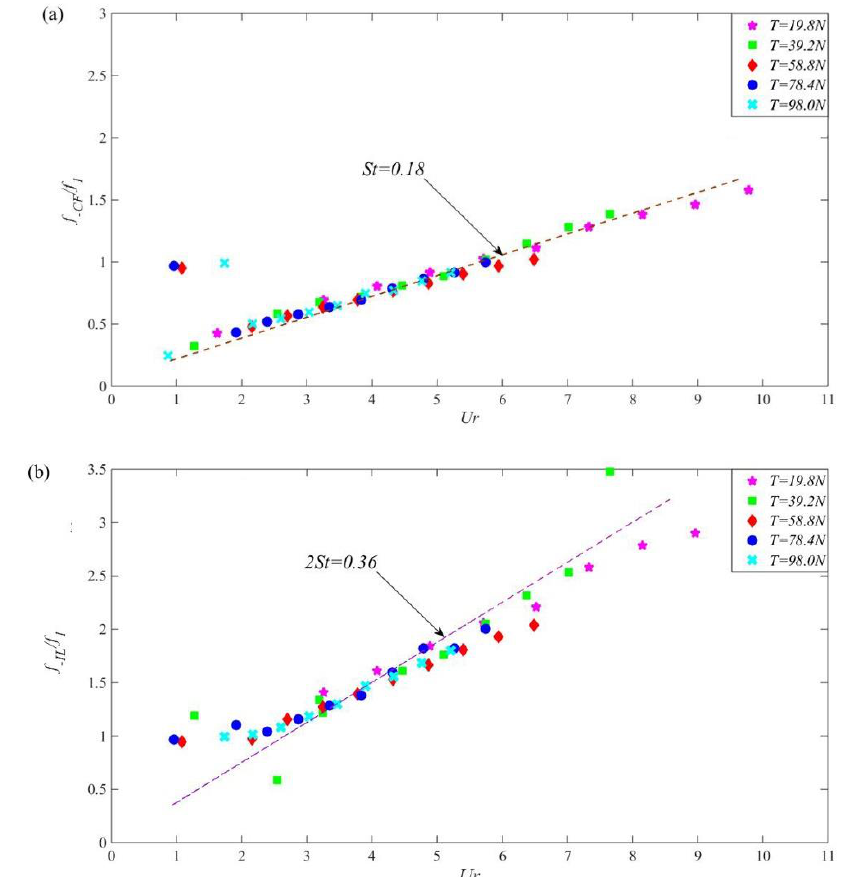
Figure 6. The dimensionless dominant frequency of VIV in the direction of cross-flow ( a ) and in-line ( b ) varies with reduced velocity and Strouhal number fitting under different top tension.